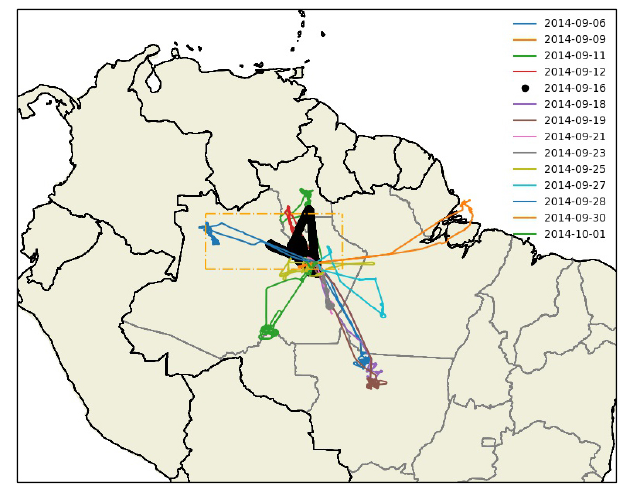
Figure 1. A map of the flight tracks during ACRIDICON–CHUVA. The flight track in black bold is AC11 (on 16 September 2014), and the orange dotted dashed box denotes the regional domain used in this